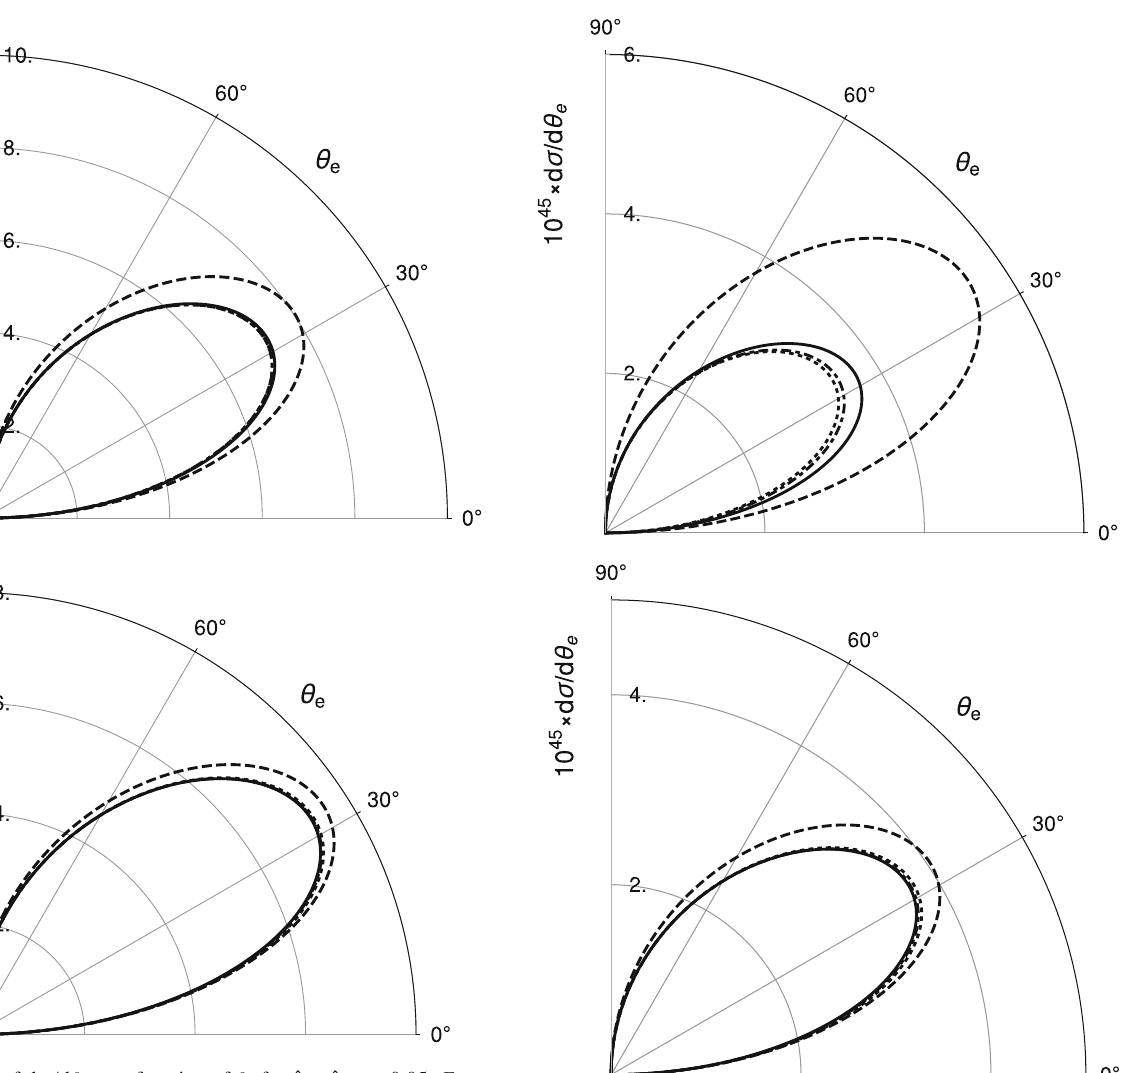
polar angle distribution of recoil electrons for the scenario with V − A and T R interactions can be noticed. For the two remaining cases the differences are much smaller. The dashed lines in Fig. 8 correspond to the case of TRSC (upper ( T ) = 33 . 7 ◦ and TRSV (lower plot) with plot) with θ max R e ( T ) = 33 . 3 ◦ , respectively. A similar regularity for the θ max R e extreme situation with θ ν = π/ 2 is seen in Fig.